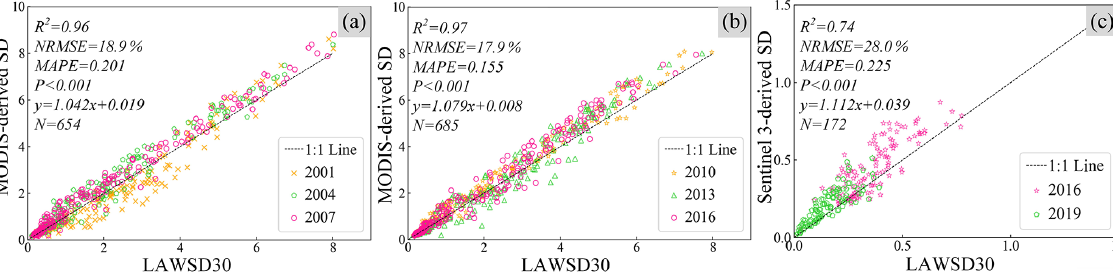
Figure 14. (a,b) Scatterplots of our LAWSD30 data and the corresponding MODIS-derived SD data (Wang et al., 2020) in the 2000s (2001, 2004, and 2007) and 2010s (in 2010, 2013, and 2016), respectively, and (c) scatterplot of our LAWSD30 data and the corresponding Sentinel 3-derived SD data (Shen et al., 2020) in 2016 and